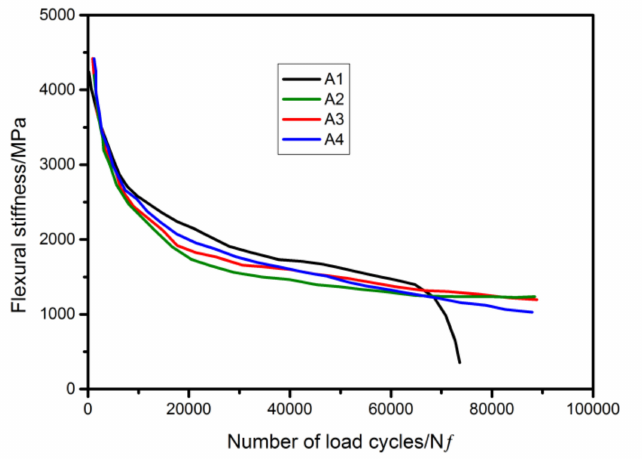
Figure 8. Fatigue performance of asphalt mixture with the